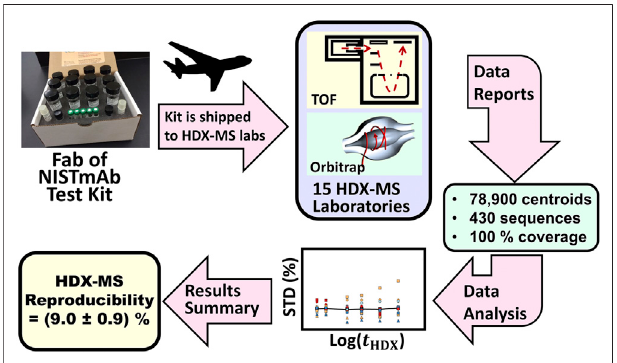
FIGURE5| SchematicdescriptionoftheHDX-MSinterlaboratorystudy. Fab of NISTmAb test kits containing standardized solutions were overnight shipped to participating laboratories. Laboratories measured peptic peptide centroids and reported these results to NIST. NIST evaluated the accumulated data to determine interlaboratory